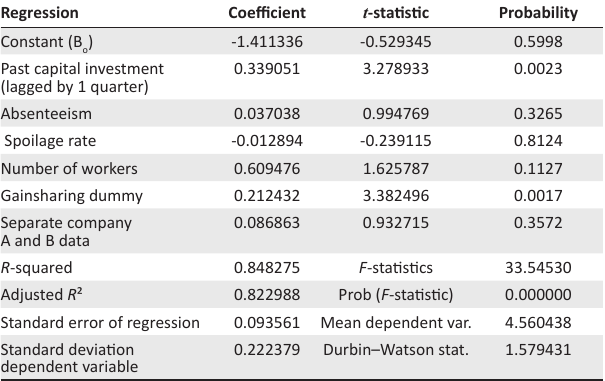
TABLE 5: Labour productivity results. Regression